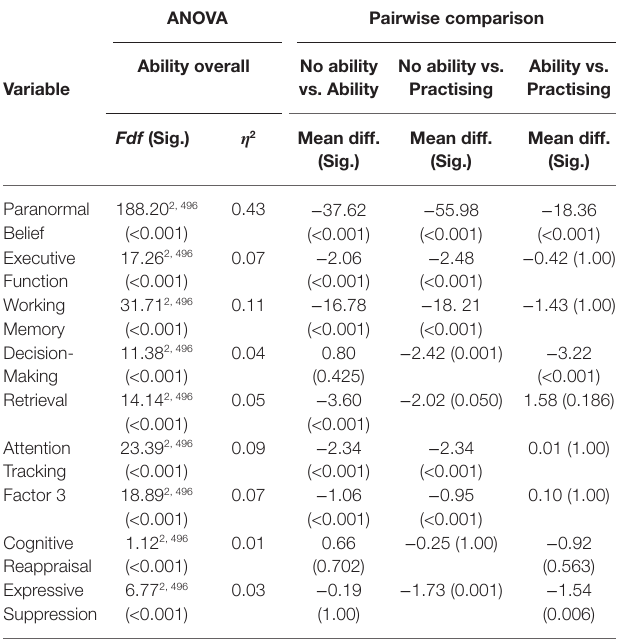
Contrast (no ability vs. ability and